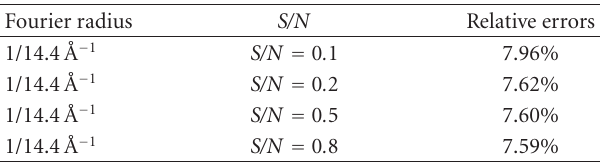
Table 4: The Relative Errors with di ff erent S/N at low Fourier frequency ( R = 1 / 14 . 4 ˚A − 1